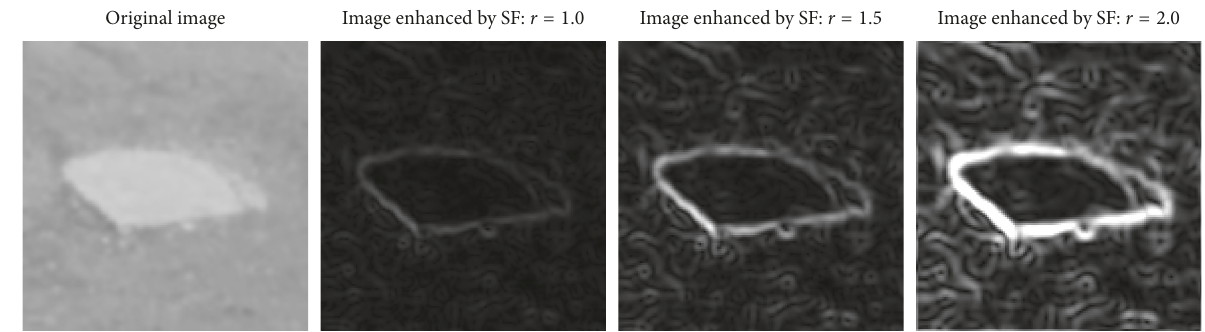
Figure 2: Image enhancement using the steerable filter with different value of r